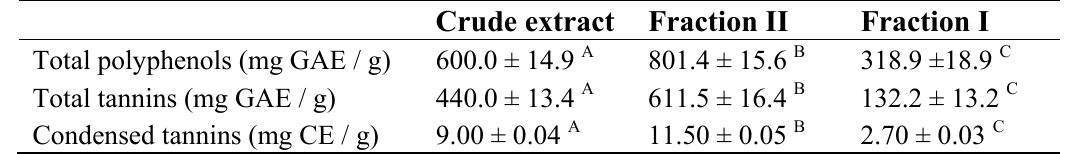
Table 2. Total polyphenols and tannins content in